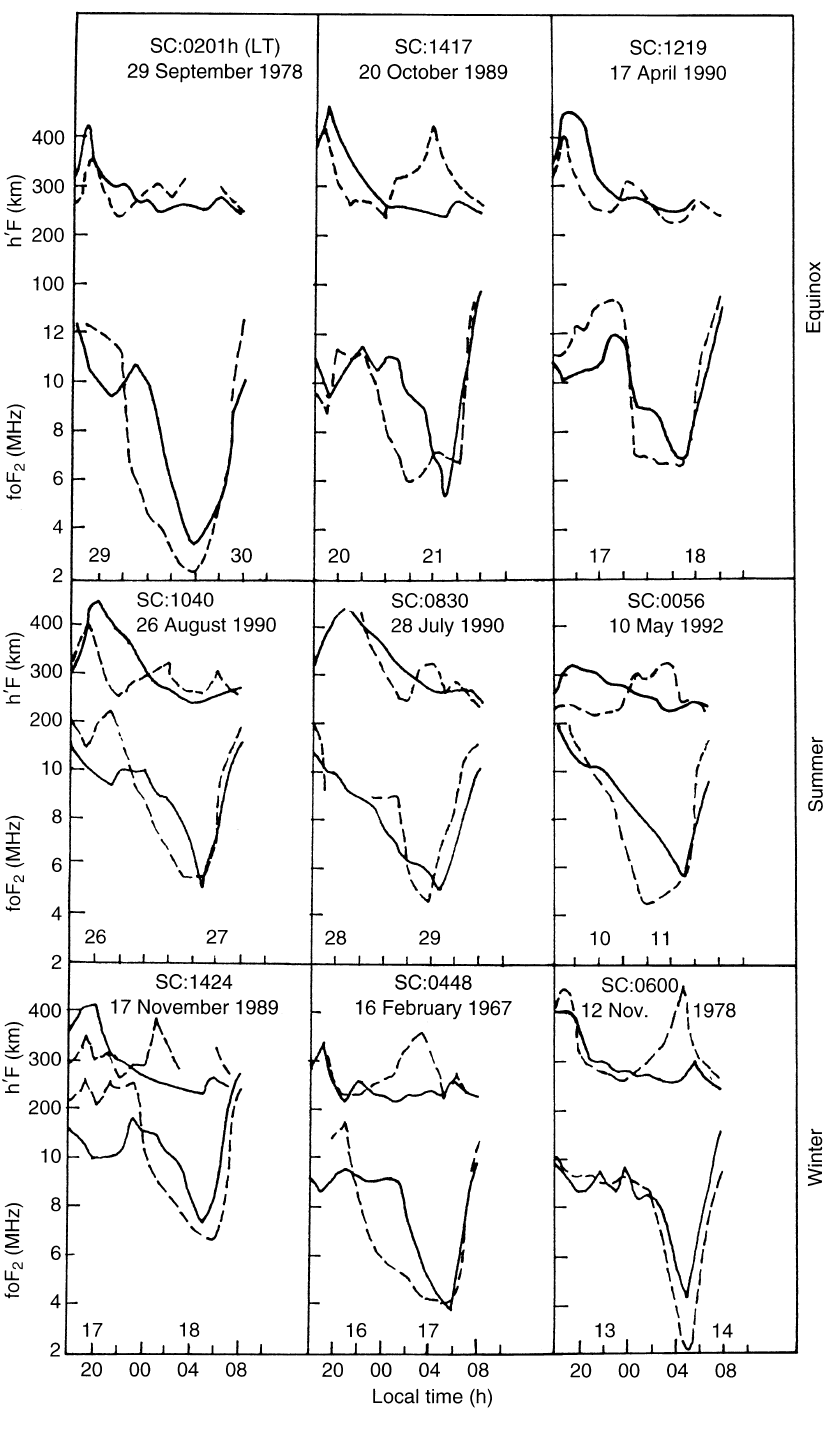
Fig. 4. Depicts sudden decrease in night-time foF2 which occurs simultaneously with sharp rise in h’F at Kodaikanal (geomagn. lat. 0.6 N) for nine specific storms on seasonal basis. The dashed line represents disturbed days while the continuous line represents the